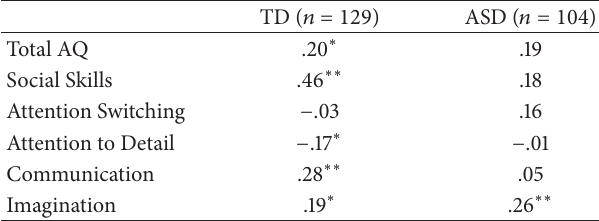
Table 7: Bivariate correlations of age and AQ subscores for TD and ASD groups.